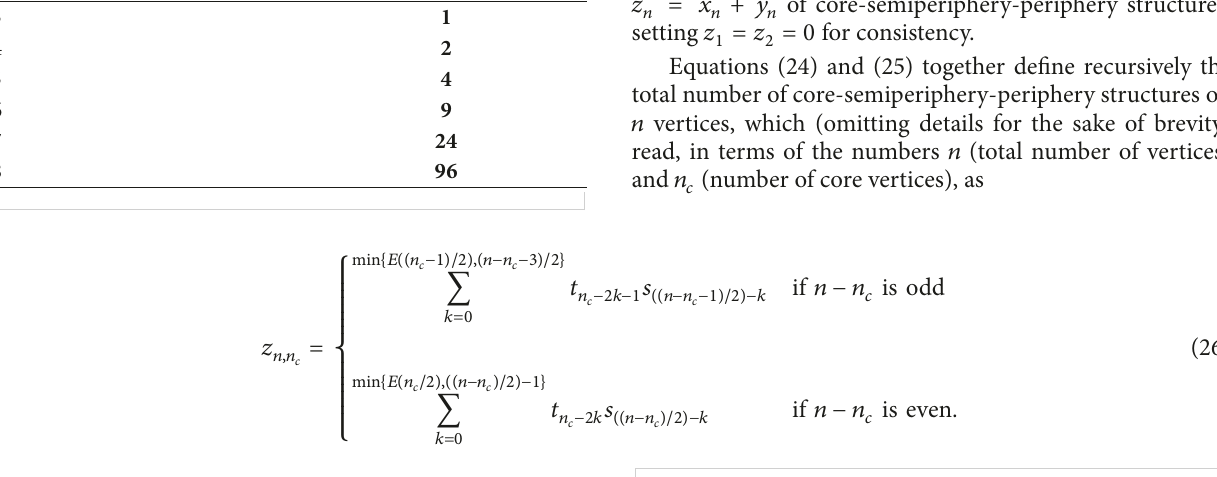
Table 2: Number of core-semiperiphery-periphery structures. Order ( 𝑛 ) Number of CSP structures ( 𝑧 𝑛